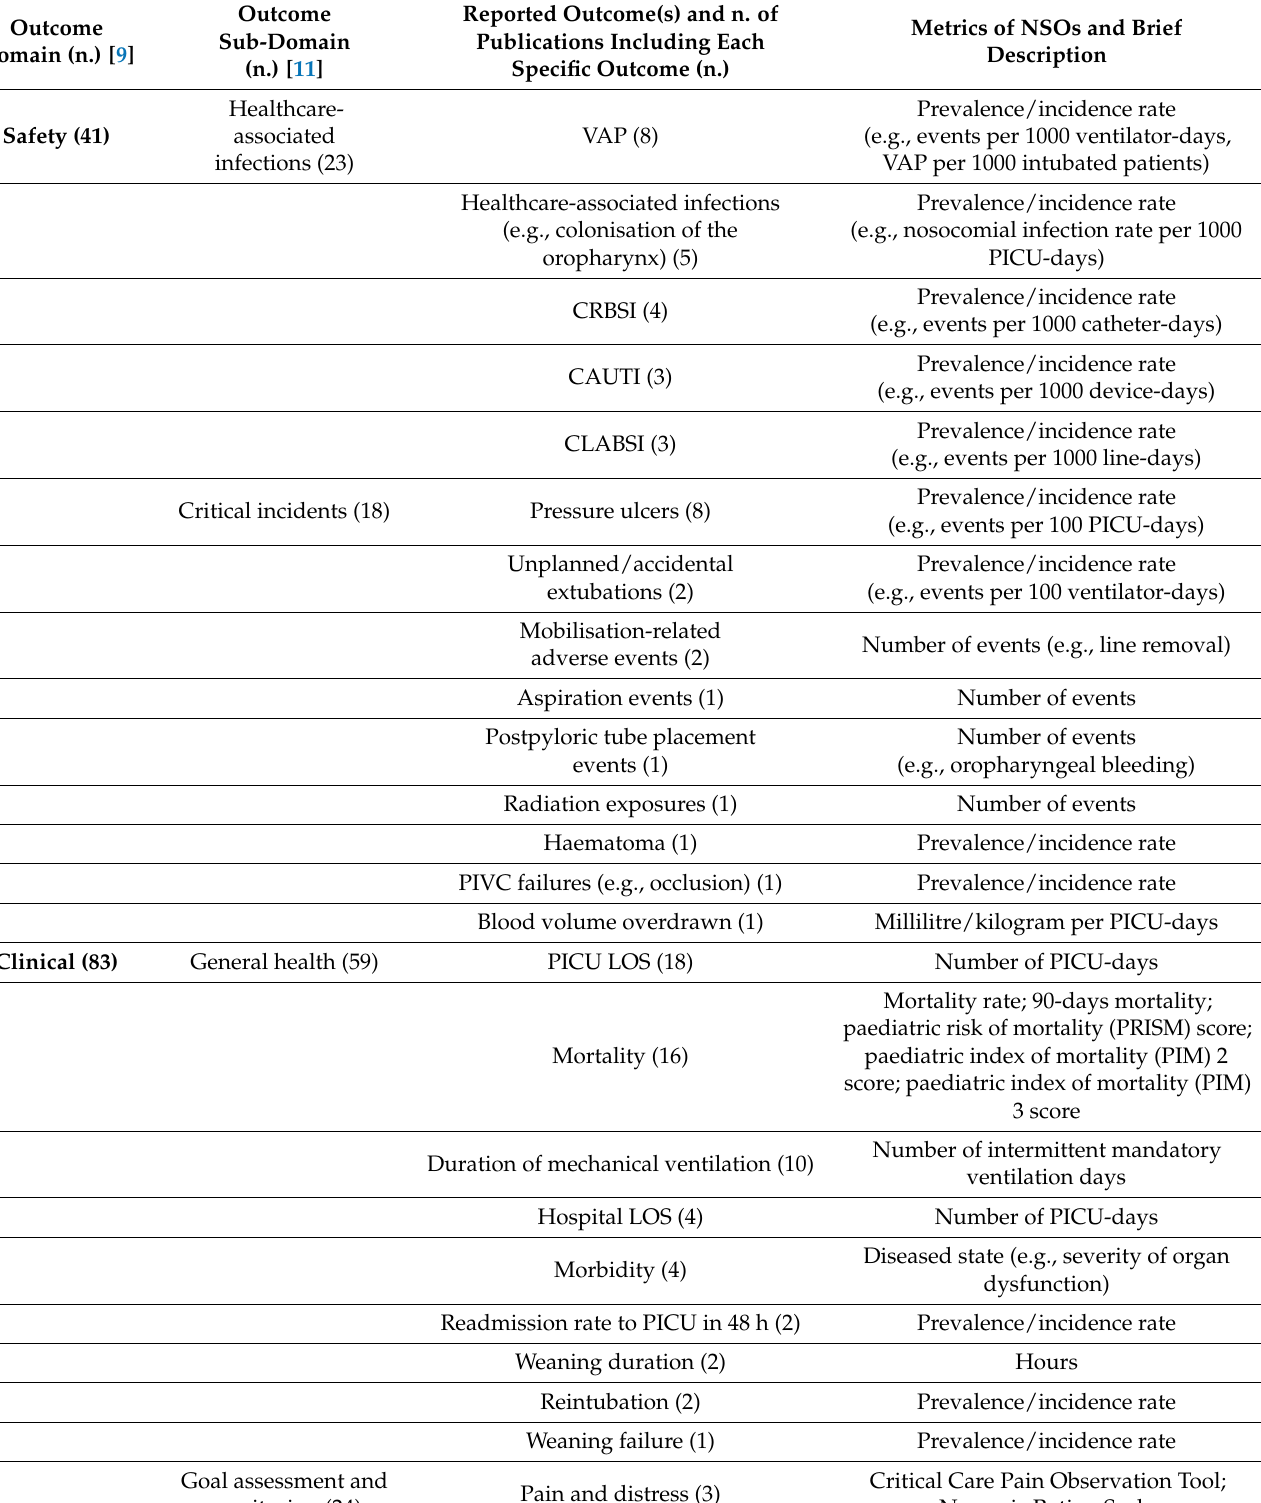
Table 4. Overview of identified NSOs in PICUs ( n = 142), according to their domain, sub-domain, and metrics used.